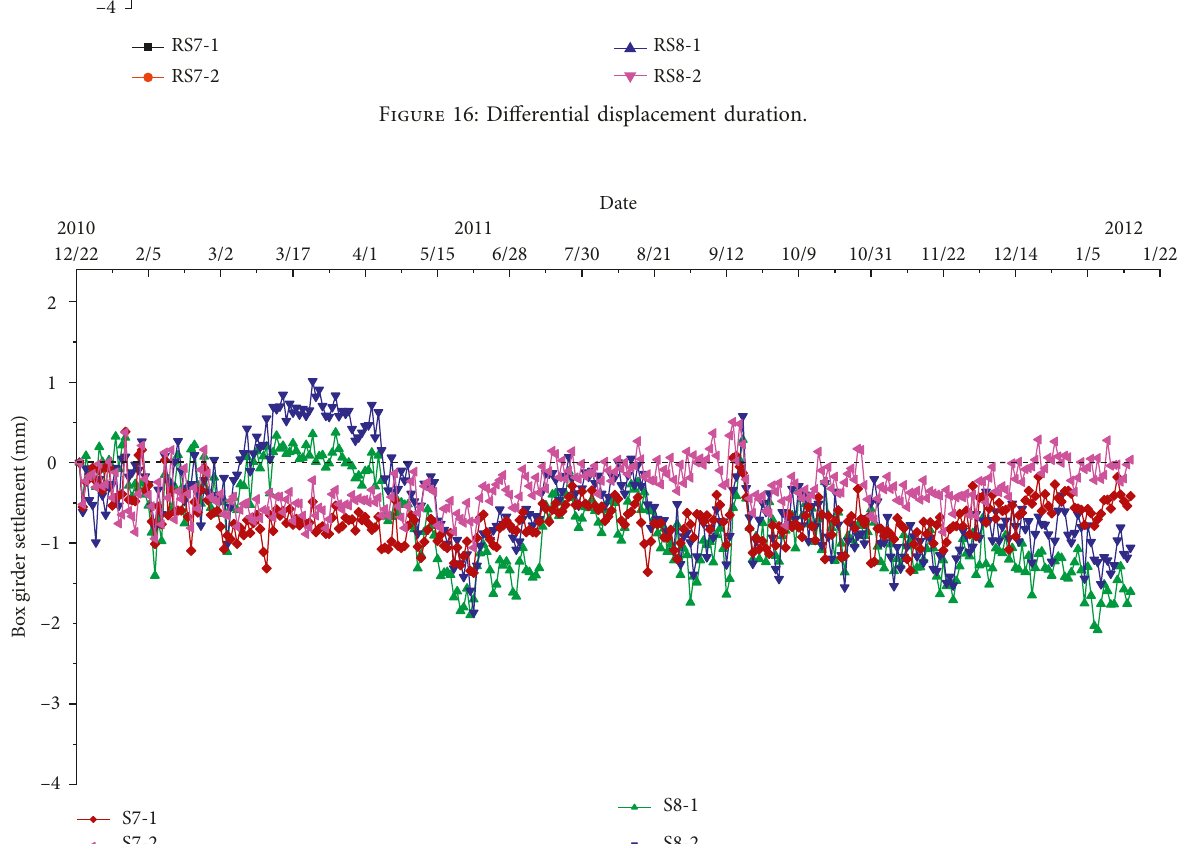
Figure 17: Settlements of pier after